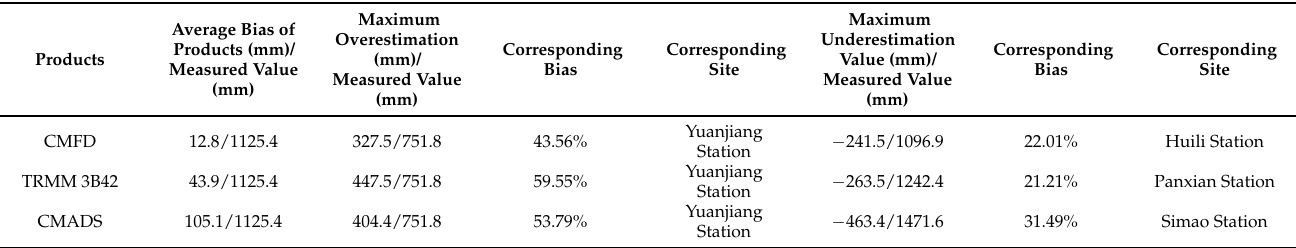
Table 7. Multiyear average deviation and maximum overestimation, low valuation, and correspond- ing sites in the study area for the three